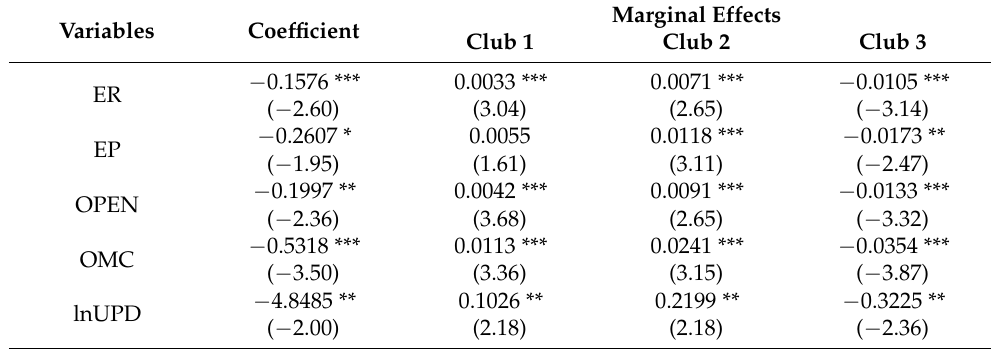
Table 7. Regression results of club convergence factors and their marginal